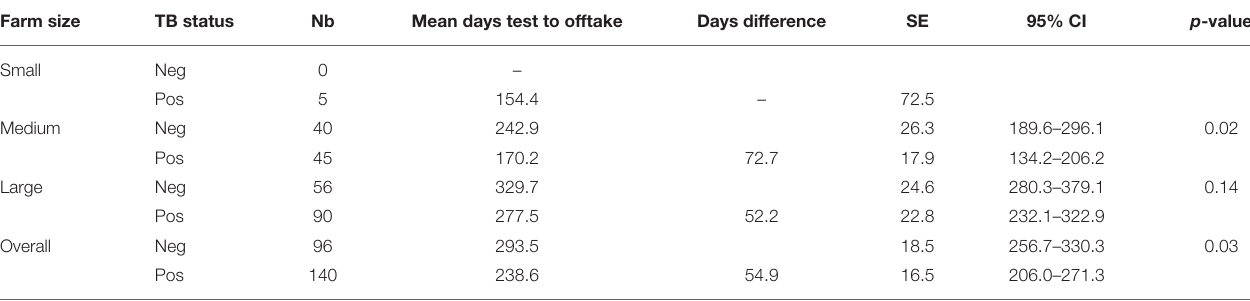
TABLE 3 | Time interval between CIDT result and offtake ( N = 236) among reactor and non-reactor animals.